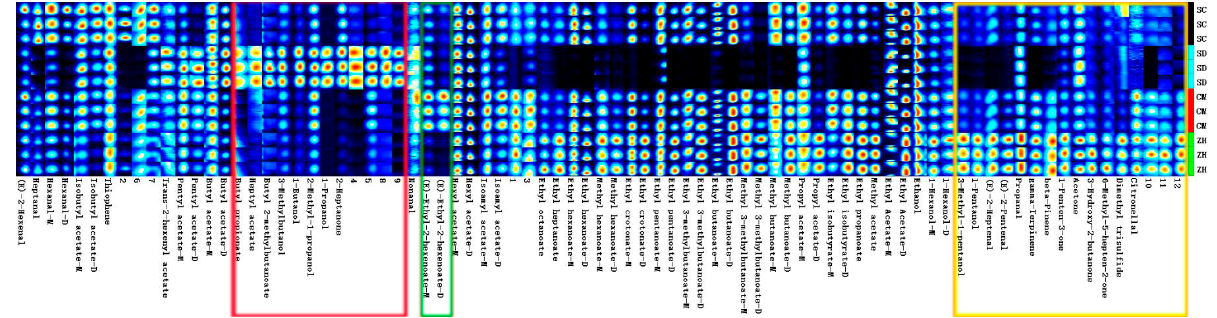
Figure 2. Fingerprints of volatile compounds in Cuiguan pears with different regions.